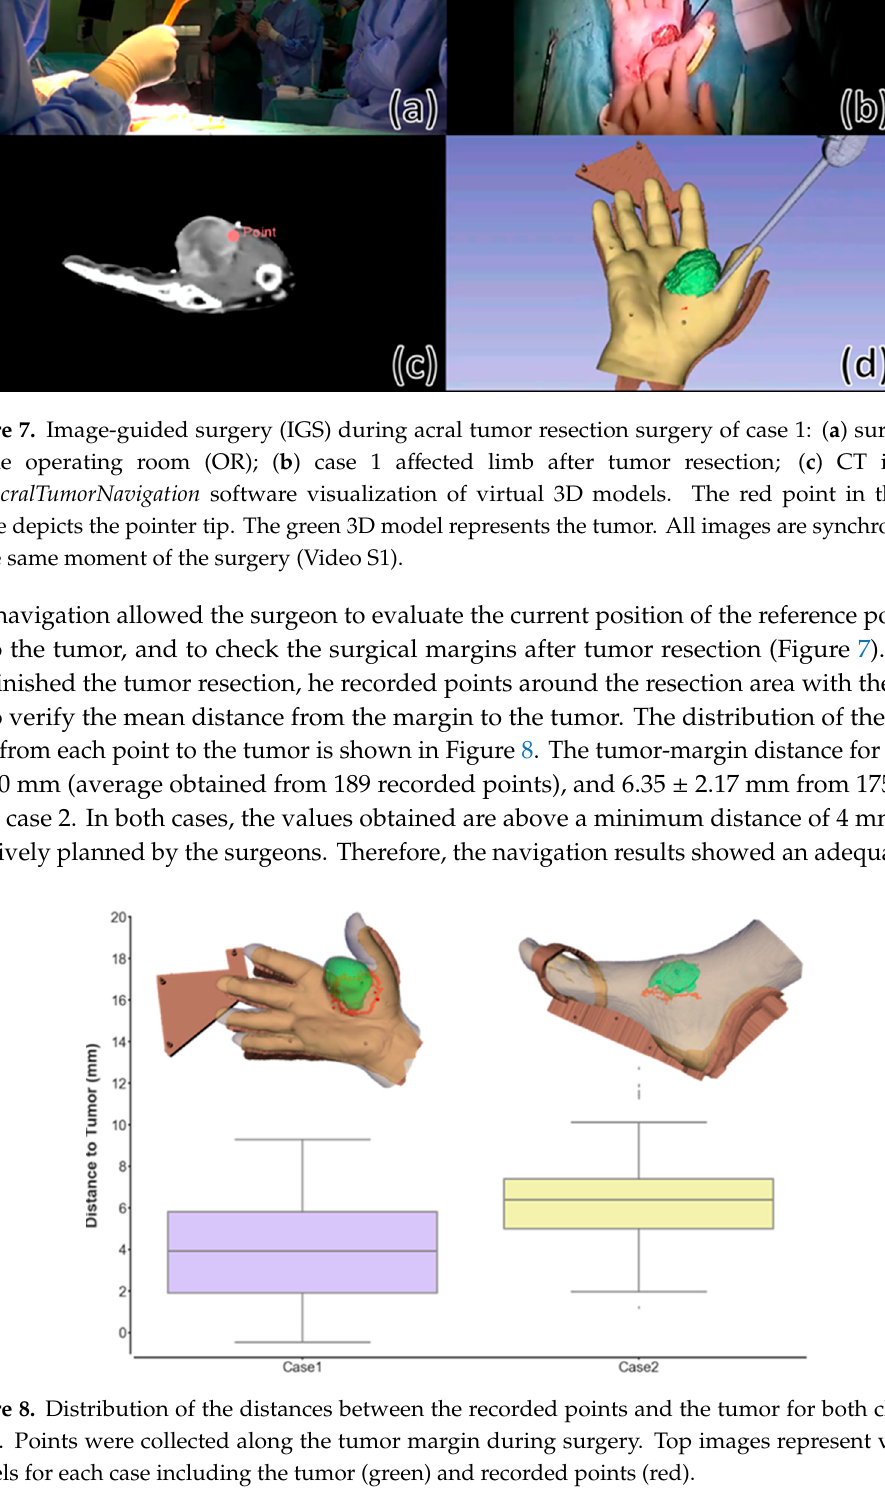
Figure 8. Distribution of the distances between the recorded points and the tumor for both clinical cases. Points were collected along the tumor margin during surgery. Top images represent virtual models for each case including the tumor (green) and recorded points (red).